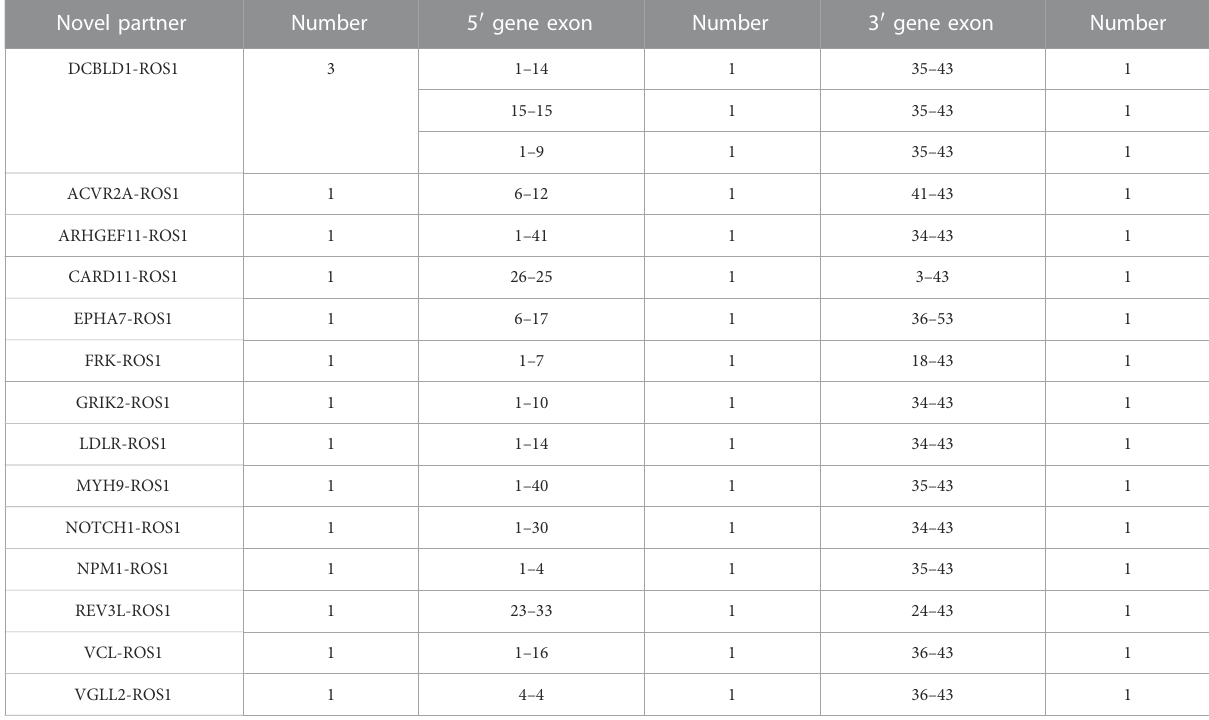
TABLE 3 ROS1 fusion variants described in novel ROS1 fusion patients. Novel